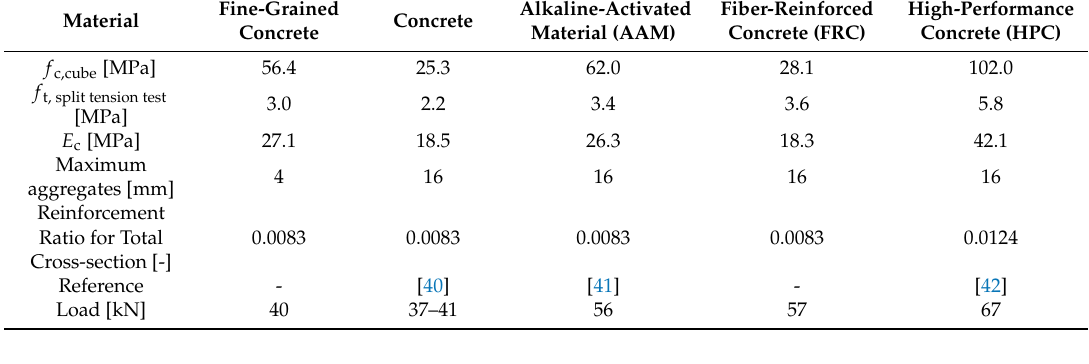
Table 1. Load capacity of reinforced concrete beams.